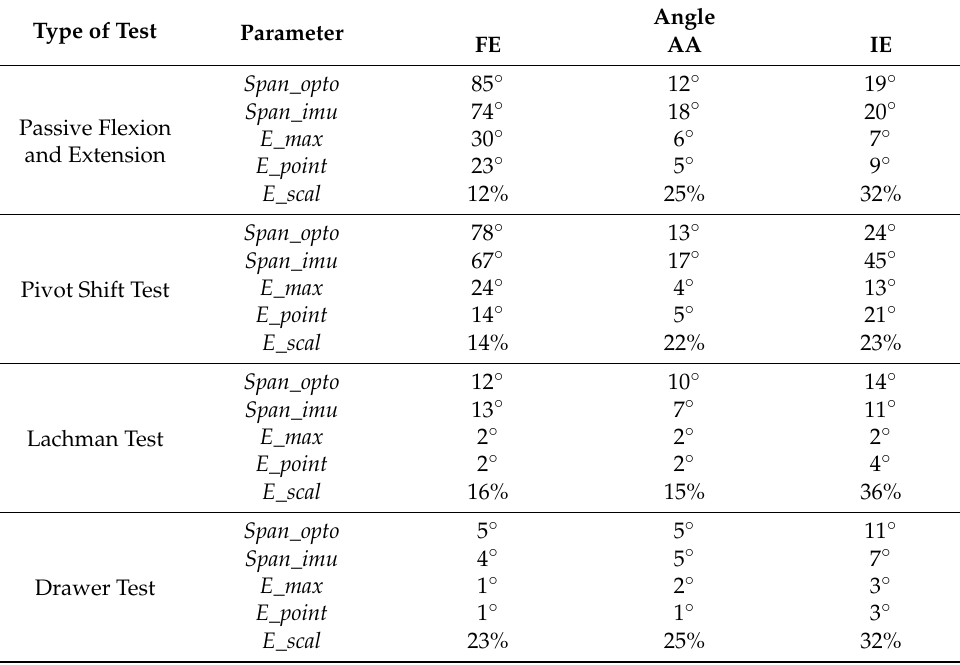
Table 1. Results of the validation tests for the IMUs of the smart brace. FE is the knee flexion and extension, AA is the adduction and abduction, and IE is the internal and external